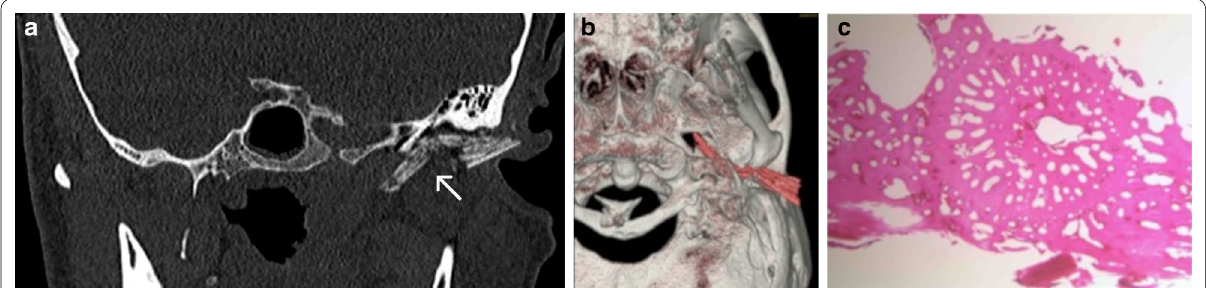
Fig. 15 Beak of a needlefish. Coronal oblique CT image ( a ) and 3‑dimensional volume rendering ( b ) showing a dislocated hyperdense foreign body (arrow) piercing through the auricle and traversing through the soft tissues rostral to the external acoustic meatus/posterior to the temporomandibular joint discus in close proximity to the petrotympanic fissure. The tip is visualised posterior to the lateral pterygoid muscle, implying its close relationship to the mandibular nerve and the maxillary artery. Photograph of histological analysis (HE staining) of stained foreign object ( c )